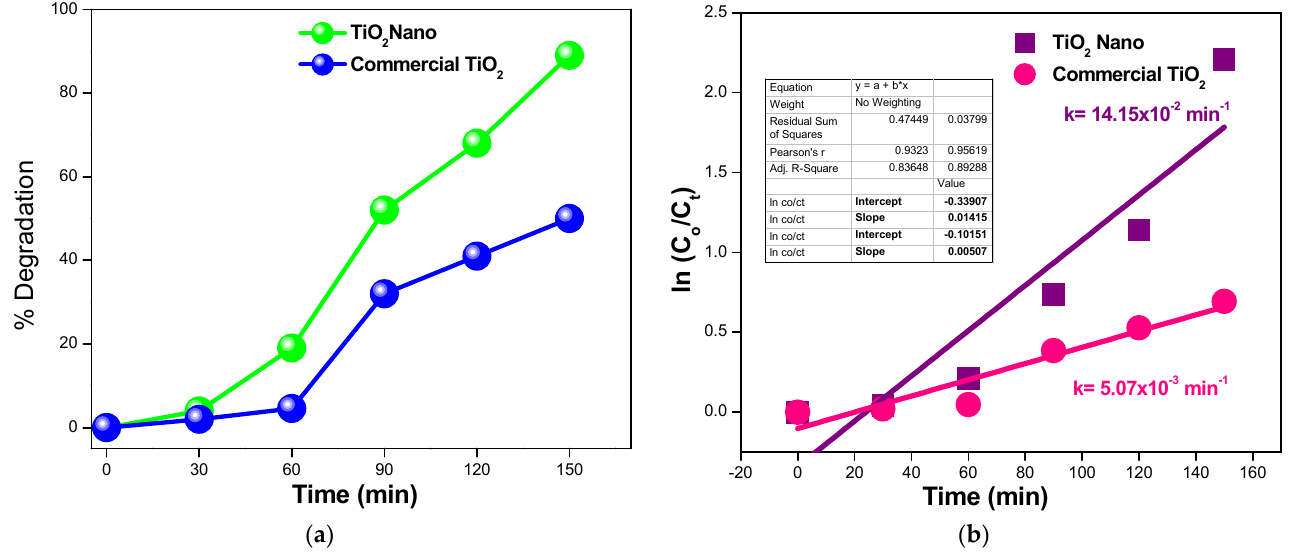
Figure 11. ( a ) Percentage degradation of dye vs. time; ( b ) kinetics of degradation of MB dye.